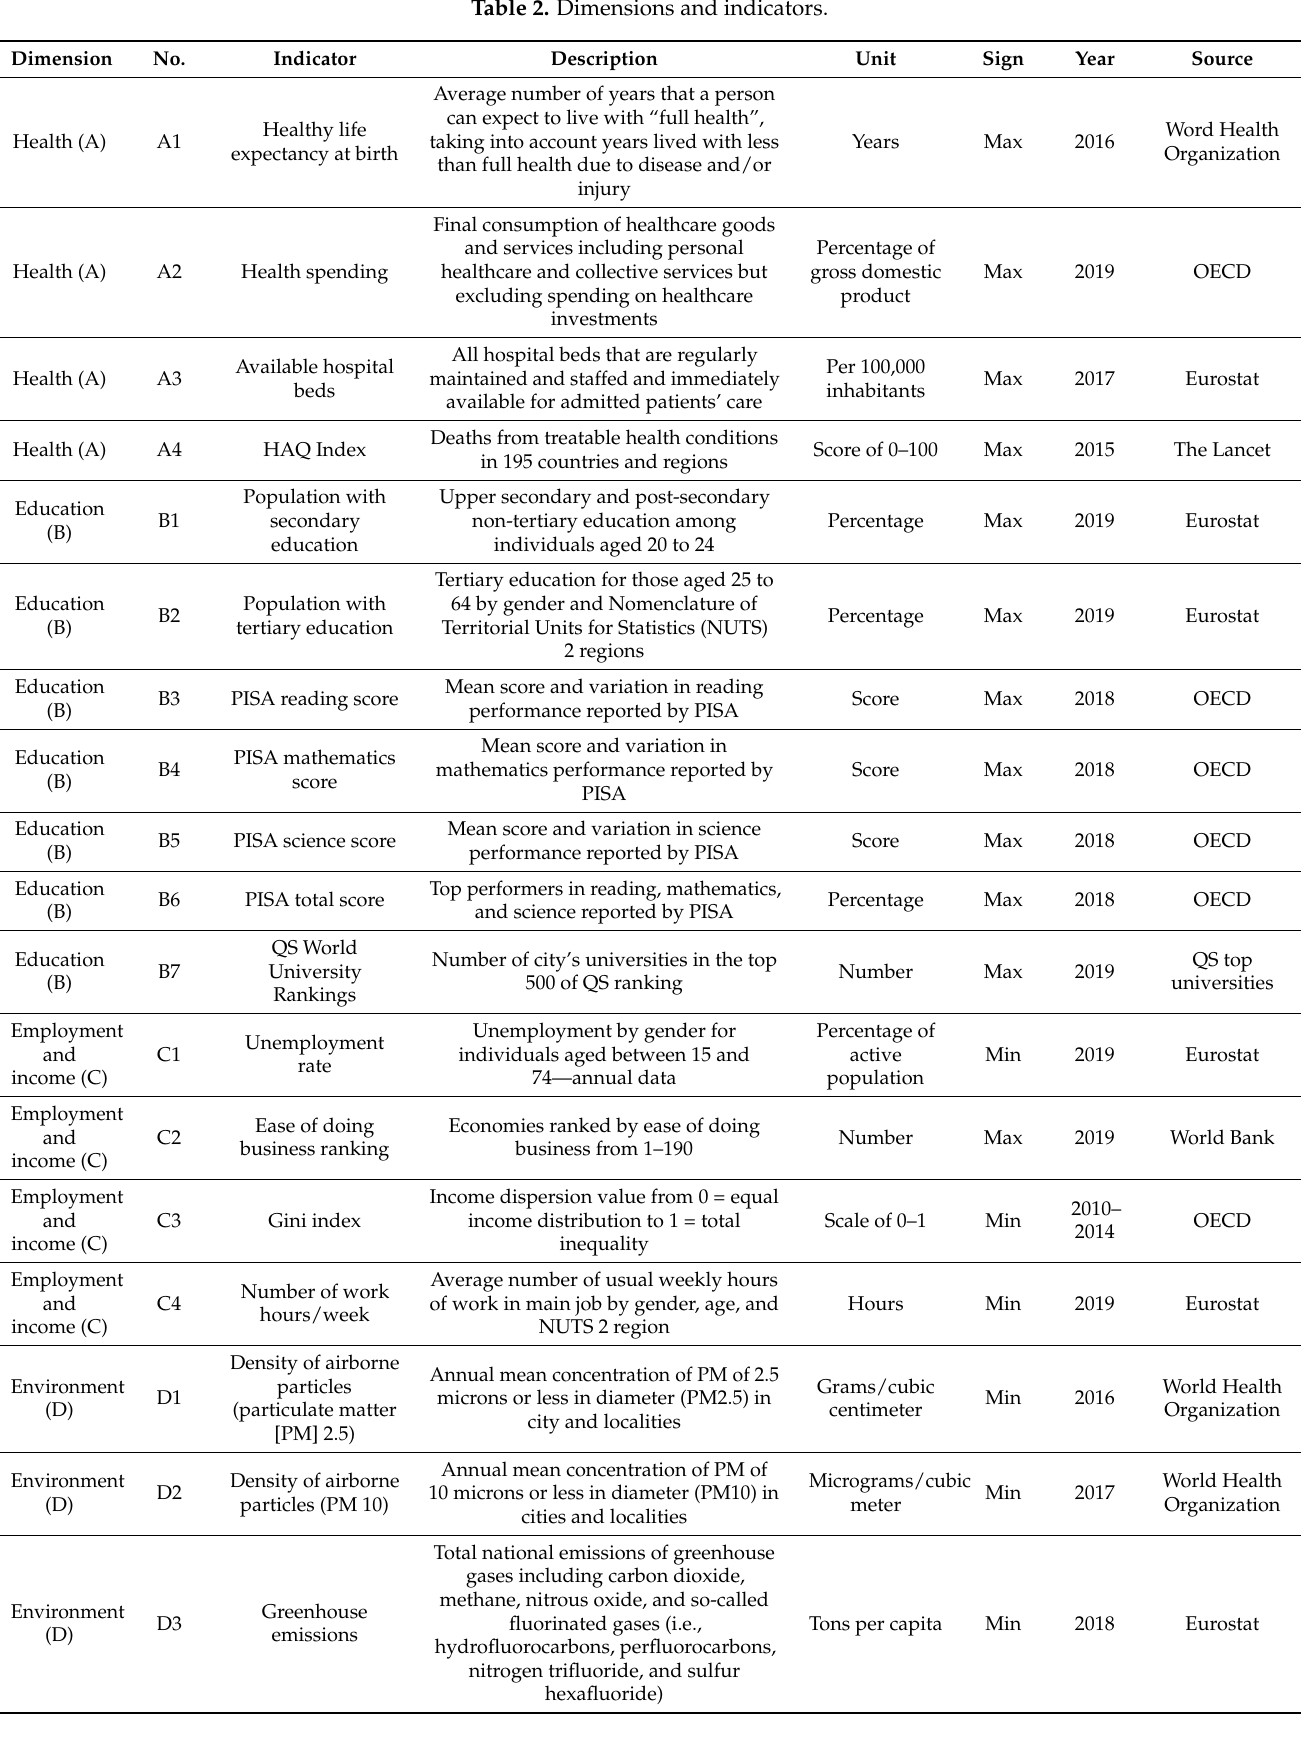
Table 2. Dimensions and